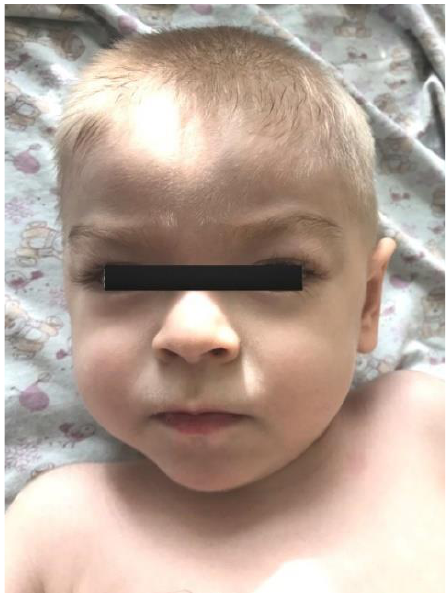
Figure 1. The proband’s facial phenotype.